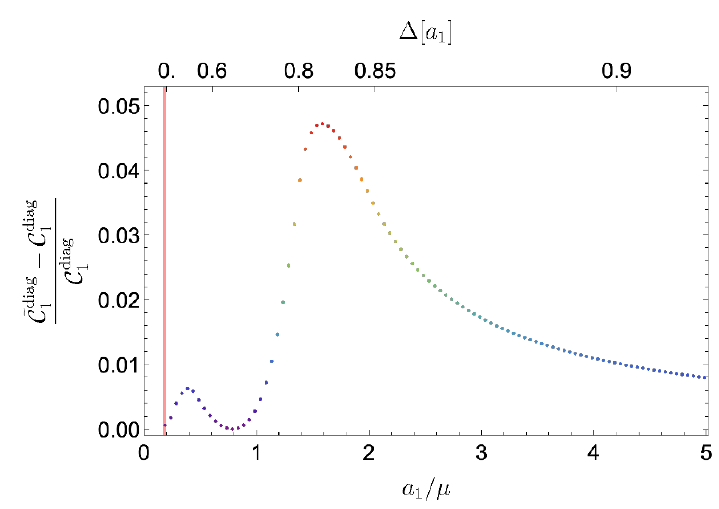
Figure 8 . The relative di(cid:11)erence between the mode-by-mode ‘complexity’ ~ C diag complexity C diag